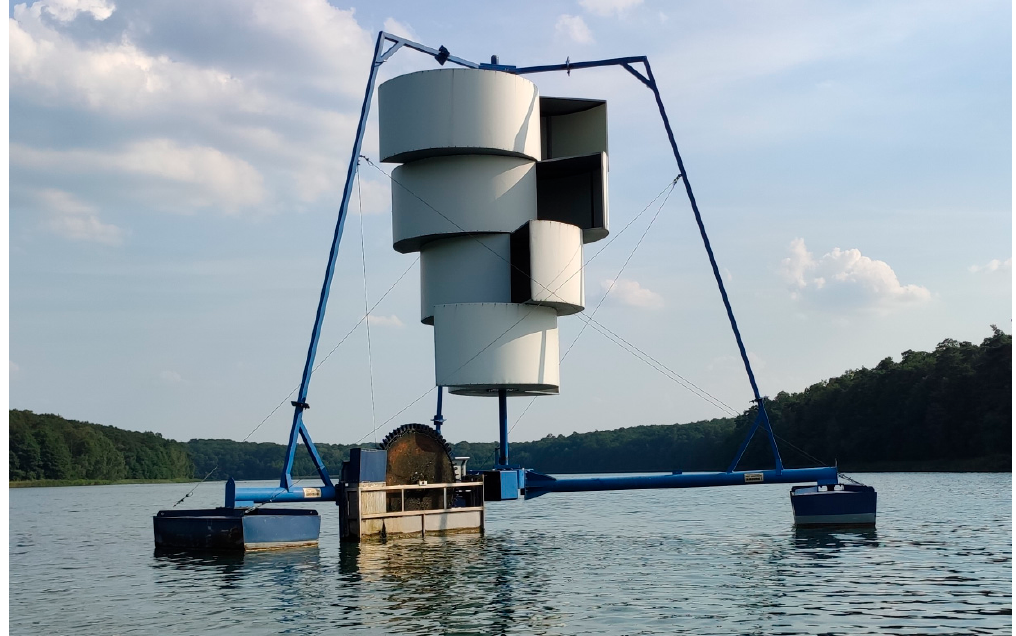
Figure 1. Wind-driven pulverizing aerator located on Góreckie Lake.